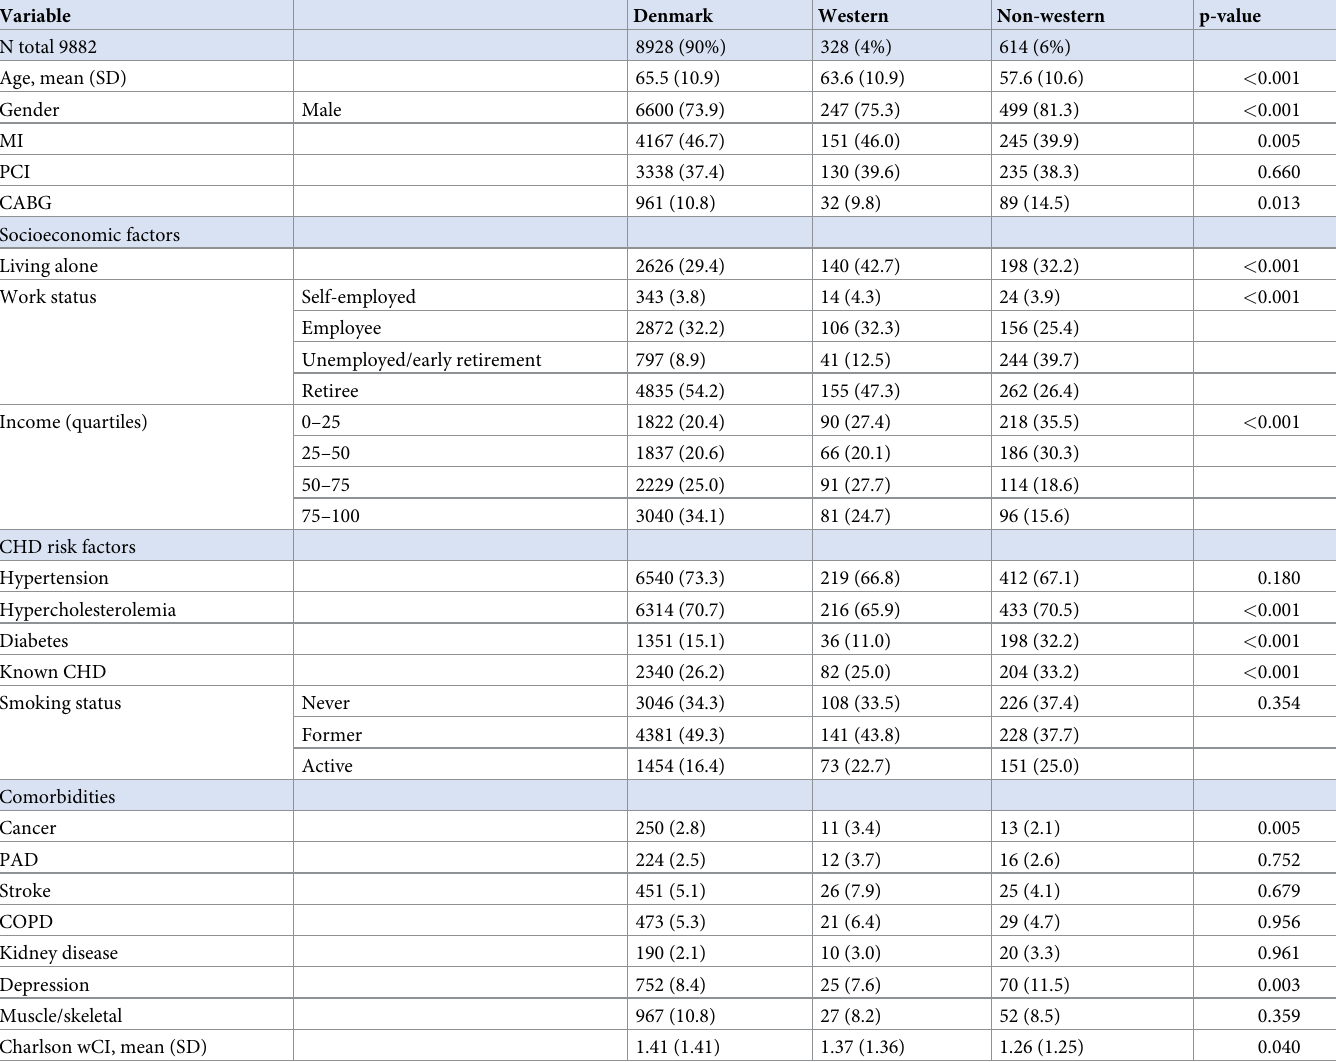
Table 2. Demographic characteristics, socioeconomic factors and comorbidity by ethnicity among 9,882 patients in the DHRD